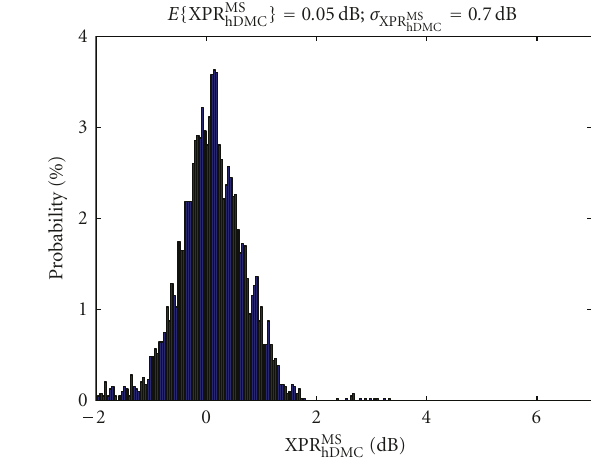
of the DMCs, macrocell Rx19 to h